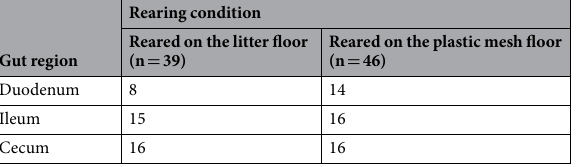
Table 1. Sample description of the Shaoxing ducks used in the study. Luminal content samples were collected from the Duodenum, Ileum, and